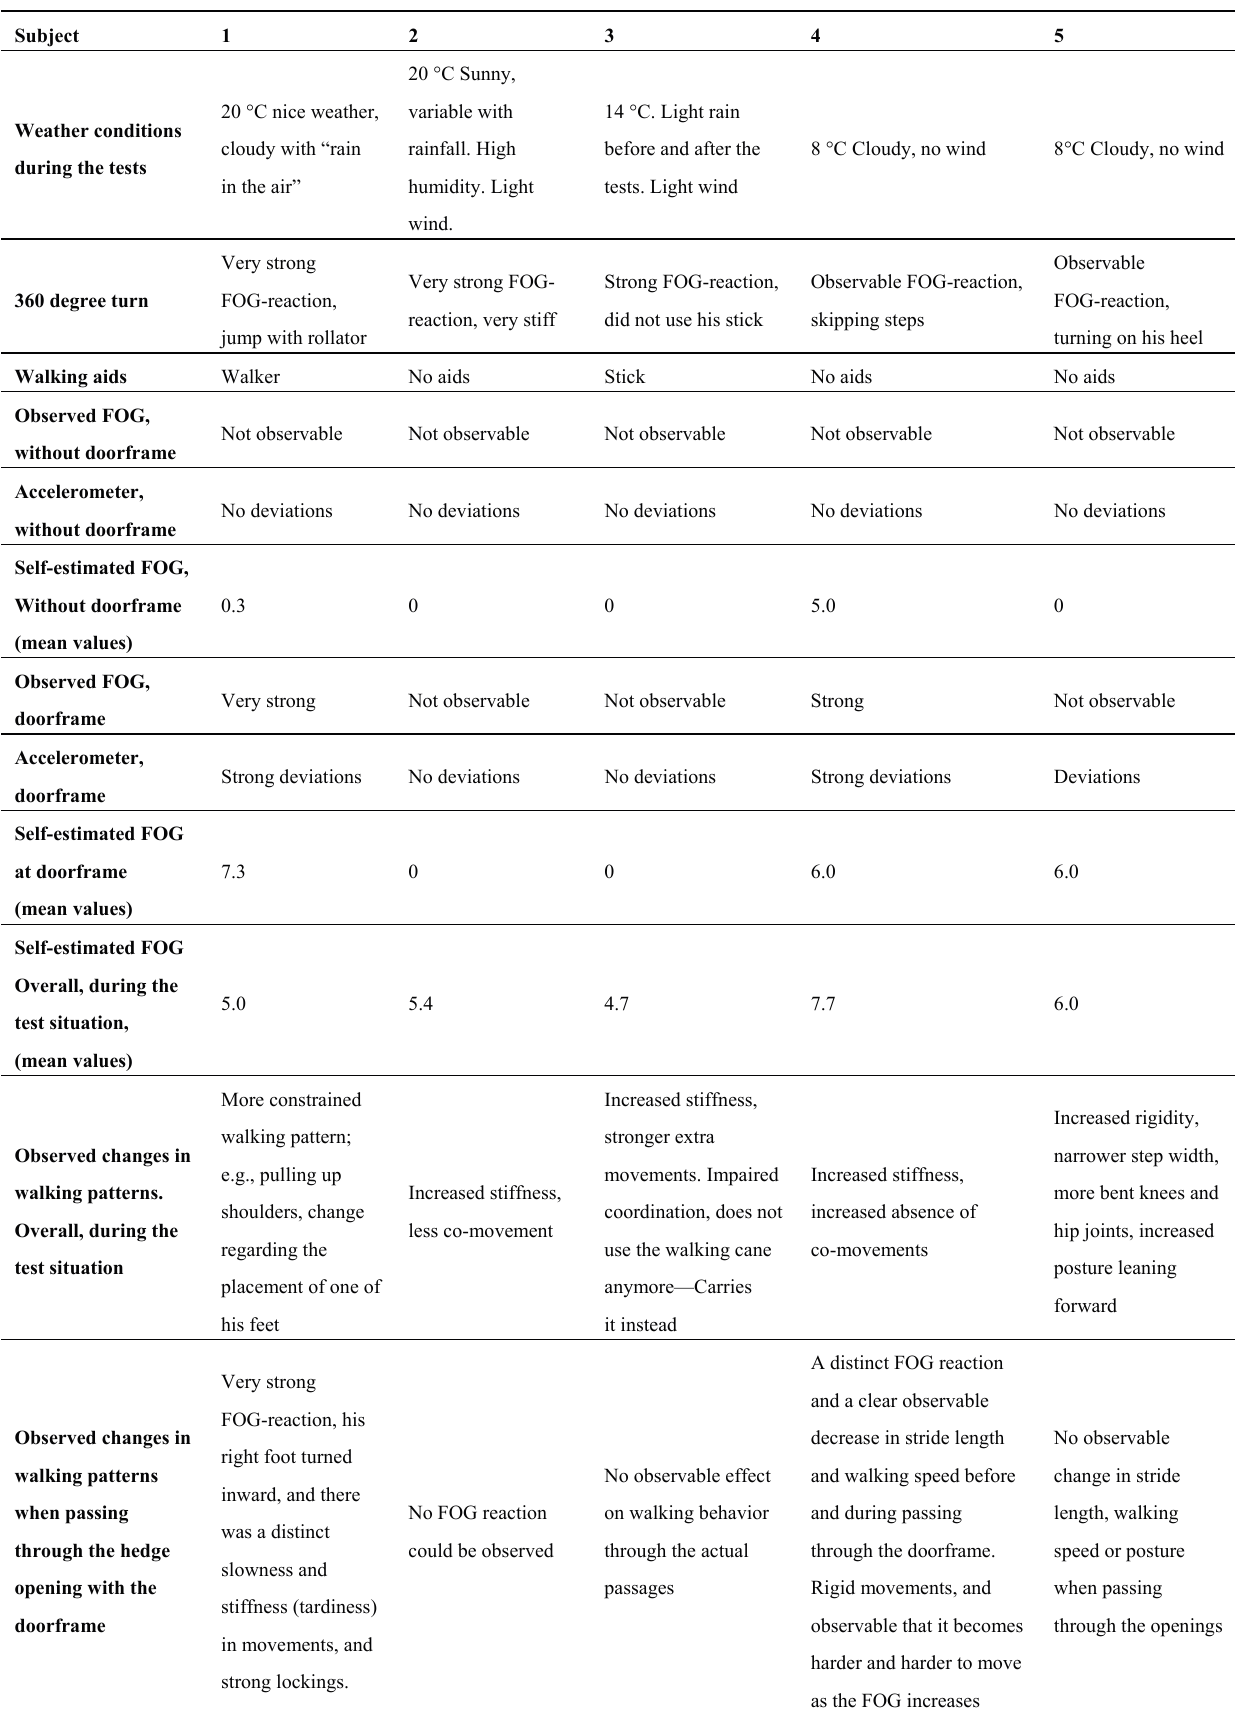
Table 2. Results from tests, observations, and self-estimations in a summary